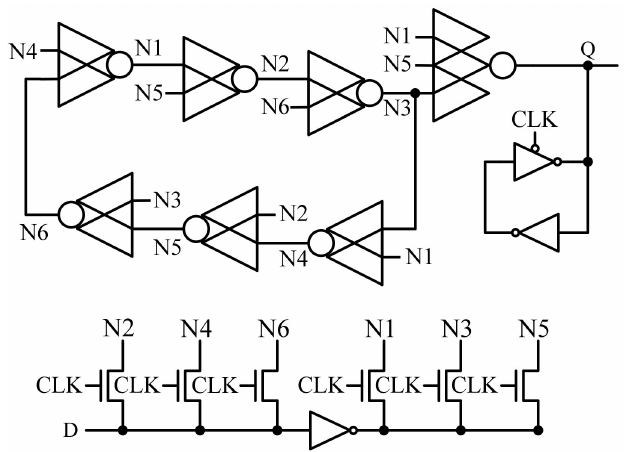
Figure 4. Schematic of DNCS latch.